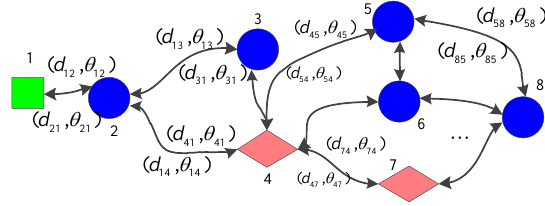
Figure 4: An example of landmark